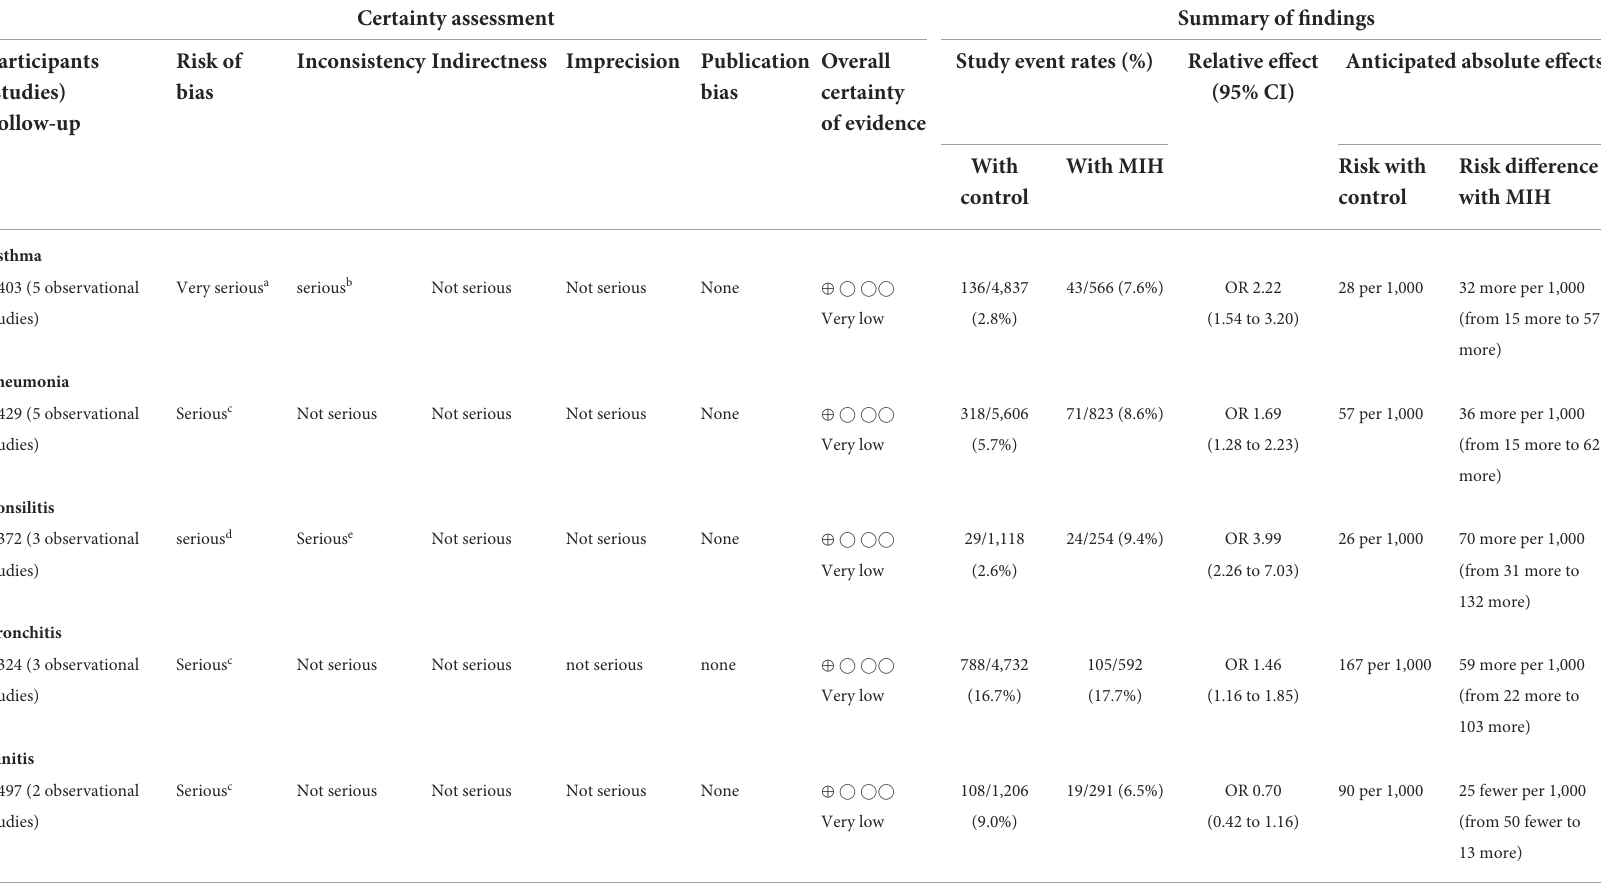
TABLE 4 Certainty of the evidence evaluation (GRADE